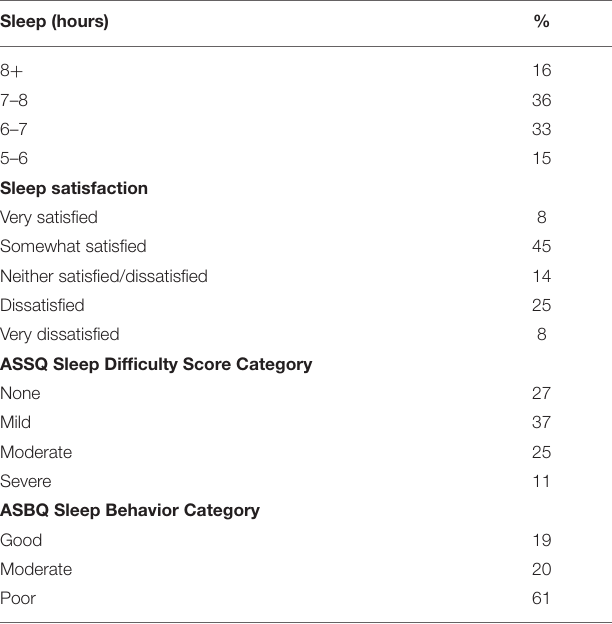
TABLE 2 | Proportional representation (%) of sleep hours, satisfaction, Athlete Sleep Screening Questionnaire SDS, and Athlete Sleep Behavior Questionnaire (ASBQ) sleep behavior categories ( n =